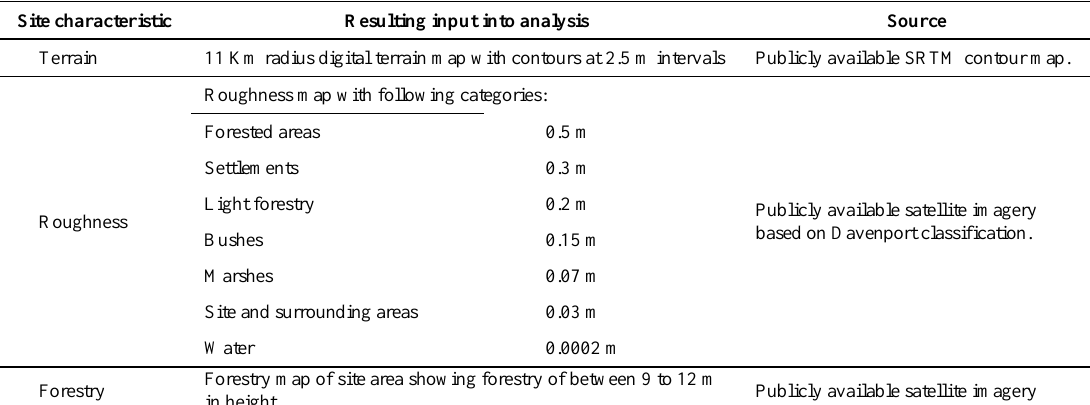
Figure 14. Map of the Sorochi Gory wind farm showing the mast location and the designed turbines layout Table 4. Shows the terrain contour, roughness and forestry maps for the